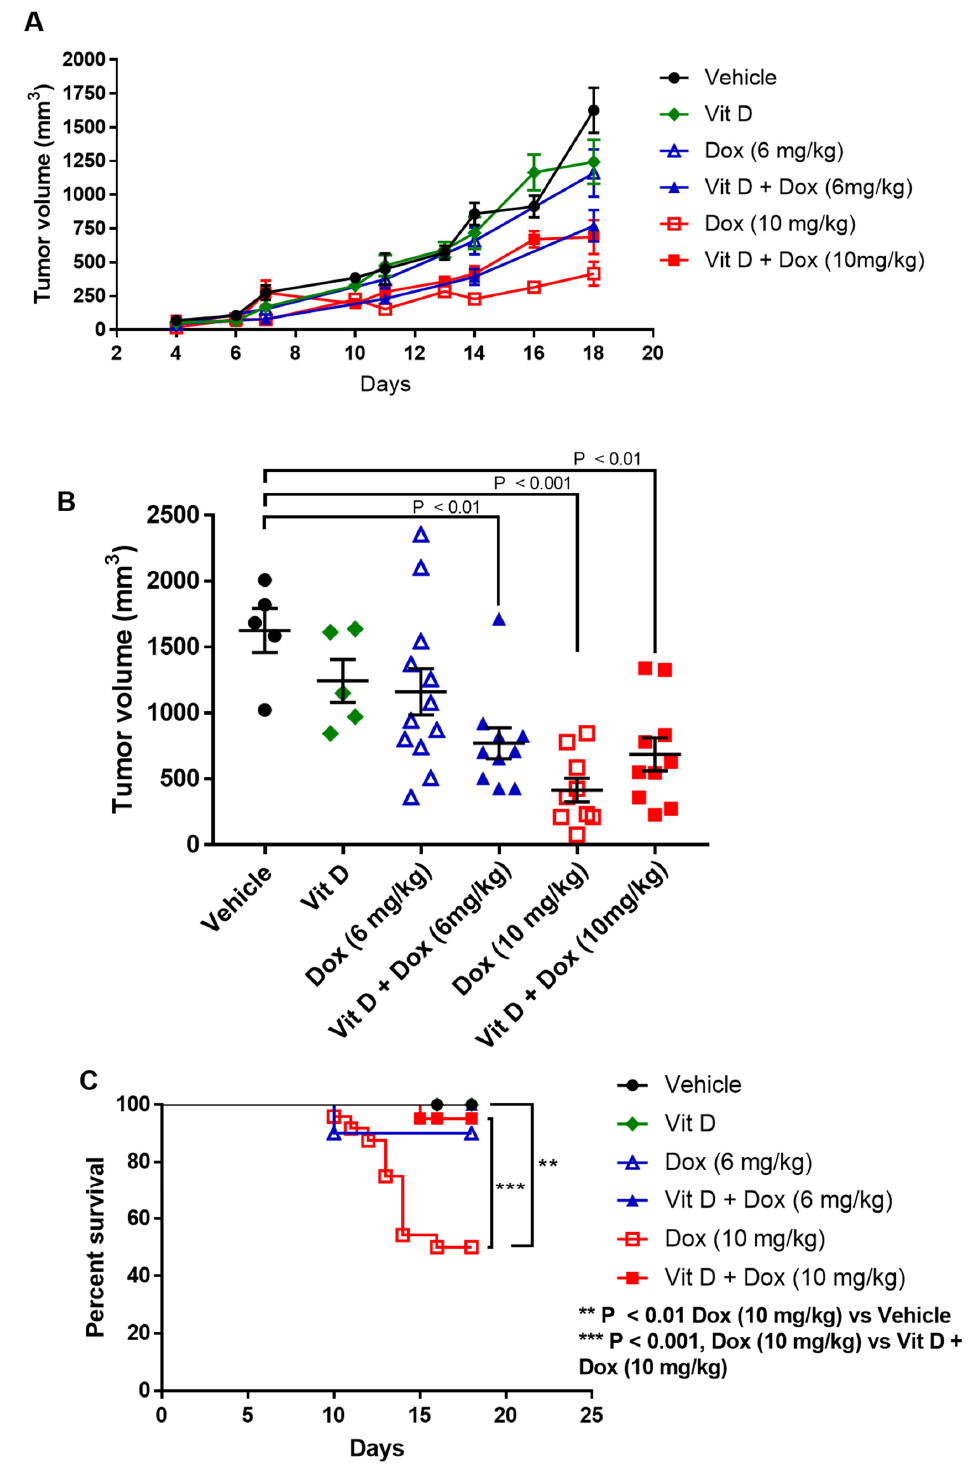
Figure 7. Vitamin D supplementation, doxorubicin treatment, and triple negative breast cancer tumor volume and survival. ( A ) Tumor volume over time. Number of mice per group on day 0: Vehicle or Vit D, 16 mice per group; Dox (6 mg/kg), 13 mice; Vit D + Dox (6 mg/kg), 10 mice; Dox (10 mg/kg), 24 mice; Vit D + Dox (10 mg/kg), 21 mice. ( B ) Tumor volume on day 18. Number of mice per group on day 18: Vehicle or Vit D, 5 mice per group; Dox (6 mg/kg), 12 mice; Vit D + Dox (6 mg/kg), 10 mice; Dox (10 mg/kg), 9 mice; Vit D + Dox (10 mg/kg), 10 mice. ( C ) Kaplan-Meier curves for mice treated with Vit D and